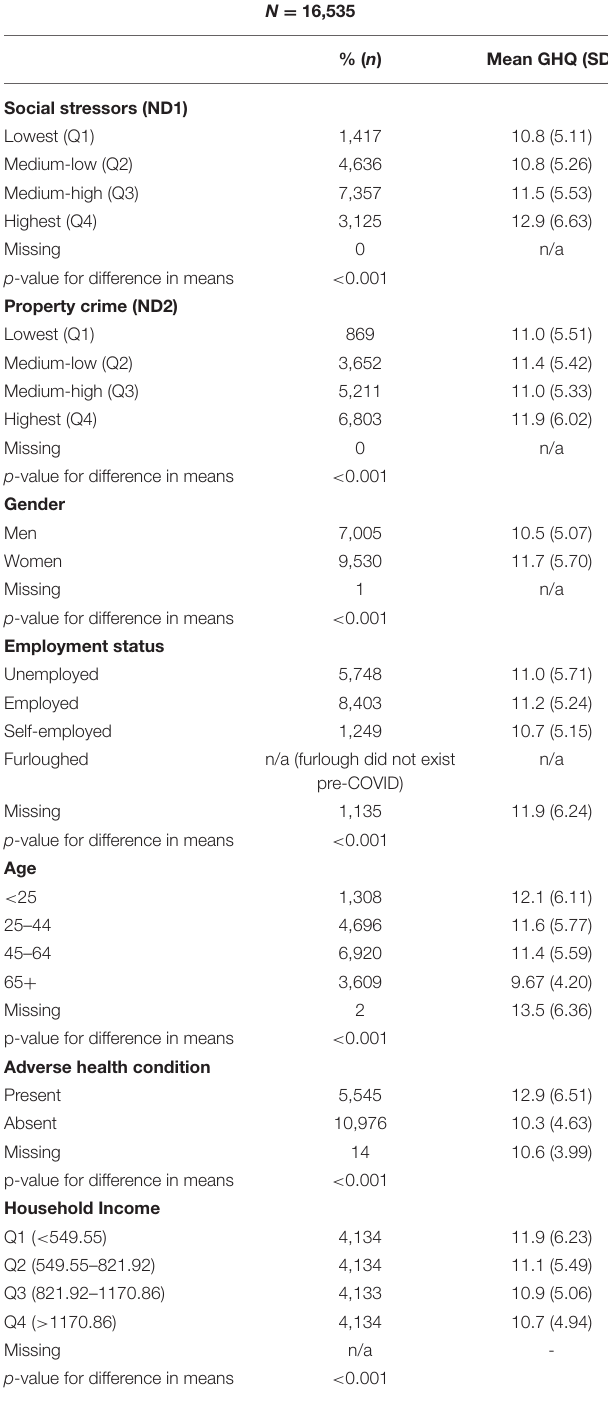
TABLE 1 | Baseline characteristics of study cohort from UK Household Longitudinal Study, n =